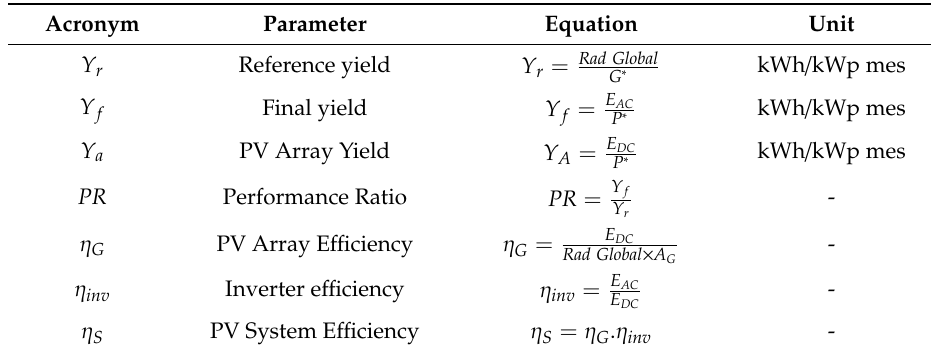
Table 4. Performance parameters of the photovoltaic (PV)